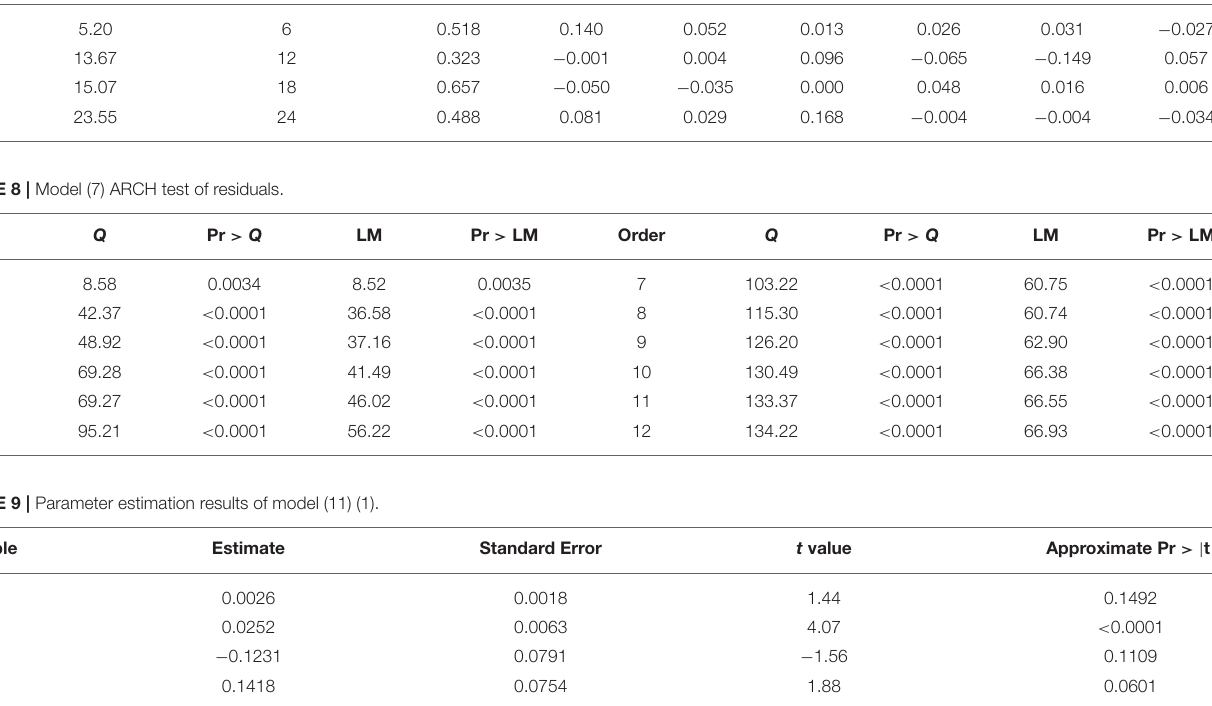
TABLE 7 | { RetSHCOMP t } serial white noise autocorrelation test results. Lag